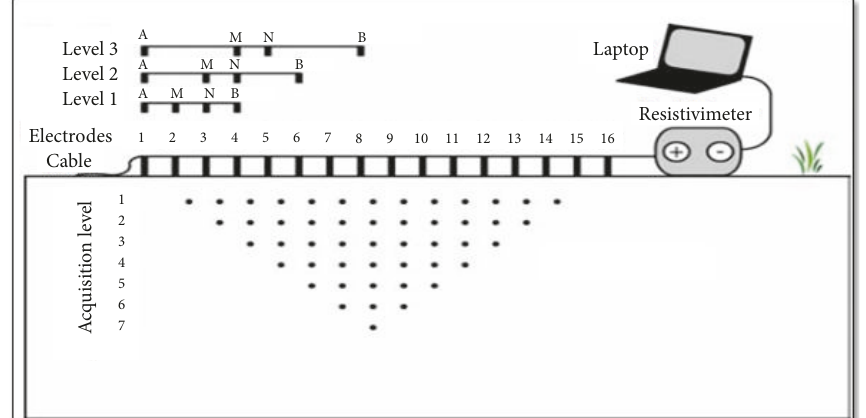
Figure 5: Implementation of 2D electric tomography (Edwards,